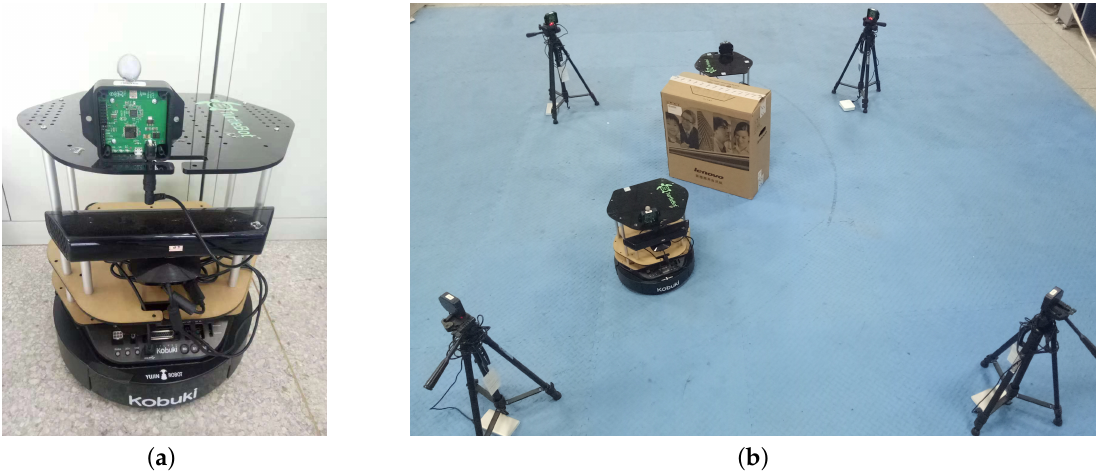
Figure 3. Inter-robot ranging experiment setup. ( a ) shows a TurtleBot2 robot with a UWB module; ( b ) depicts the overall experiment setup. The carton shown in ( b ) was used as a container for wood or metal obstacles.